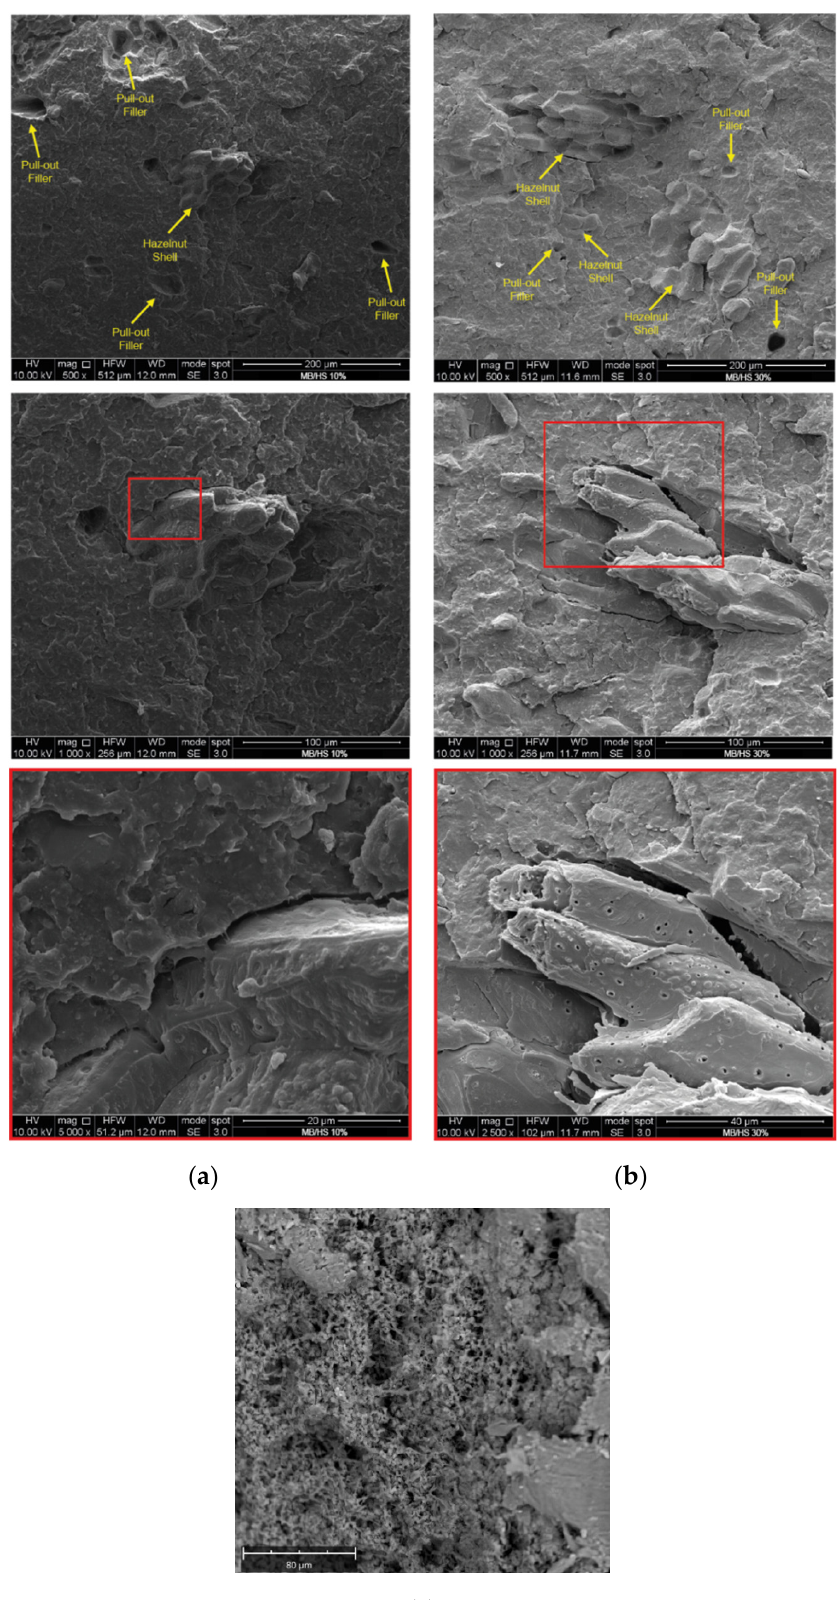
Figure 11. SEM micrographs of the two biocomposites, ( a ) MB/HS 10% and ( b ) MB/HS 30%; ( c ) MB.